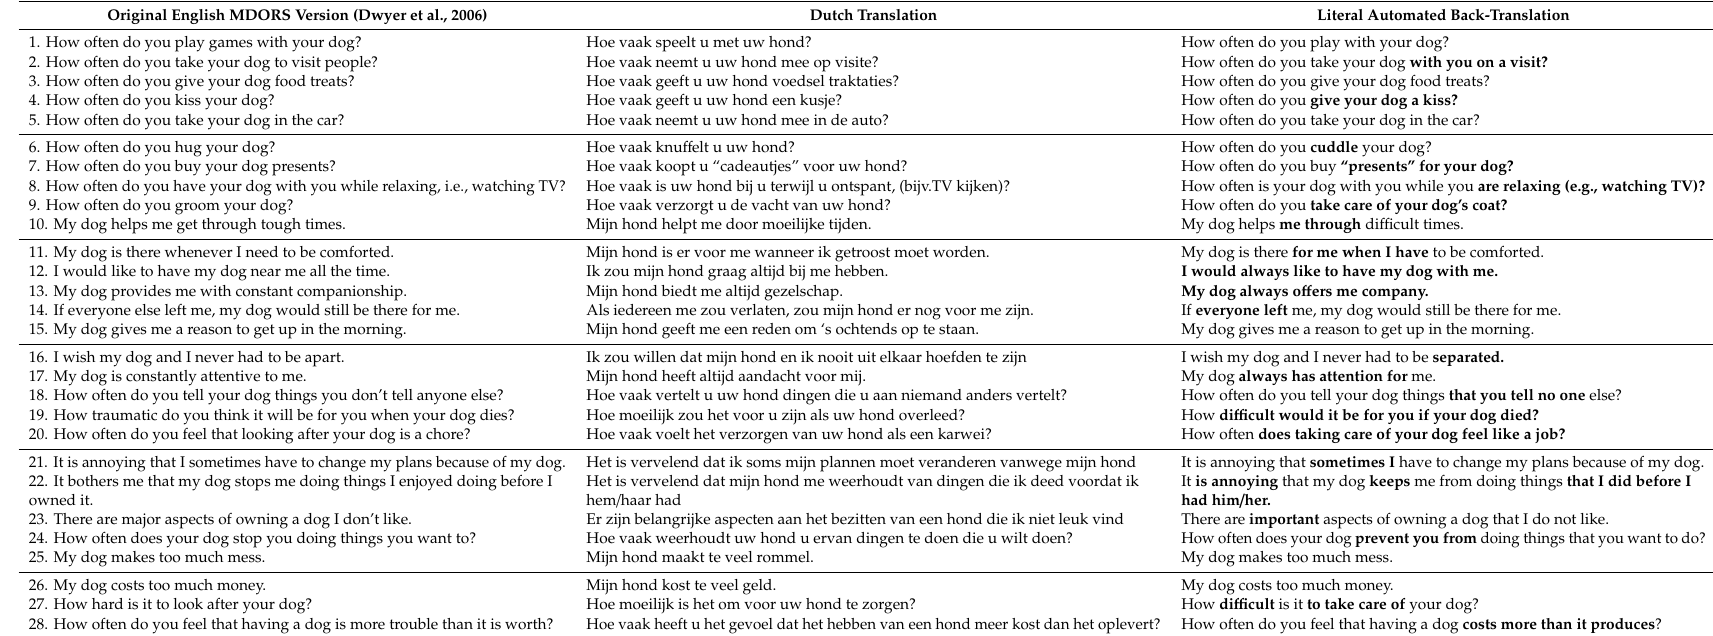
Table 1. The original English version of the Monash Dog–Owner Relationship Scale (MDORS) by Dwyer et al. [14] compared to the Dutch native speaker translation, and the automated back-translation. Deviations from the original MDORS are marked in Bold in the back-translation. Original English MDORS Version (Dwyer et al.,